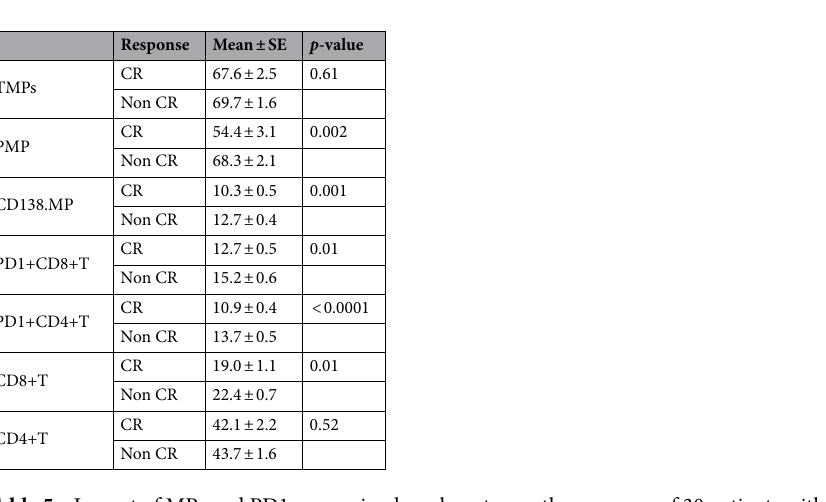
Table 5. Impact of MPs and PD1 expressing lymphocytes on the response of 30 patients with active MM. TMP: total microparticles; PMP: platelet microparticles; CR: complete response; PD1: programmed death-1; Mann Whitney test was applied for TMP, PMP, PD1+CD4+T, and CD4 and independent sample t-test was applied for the remaining